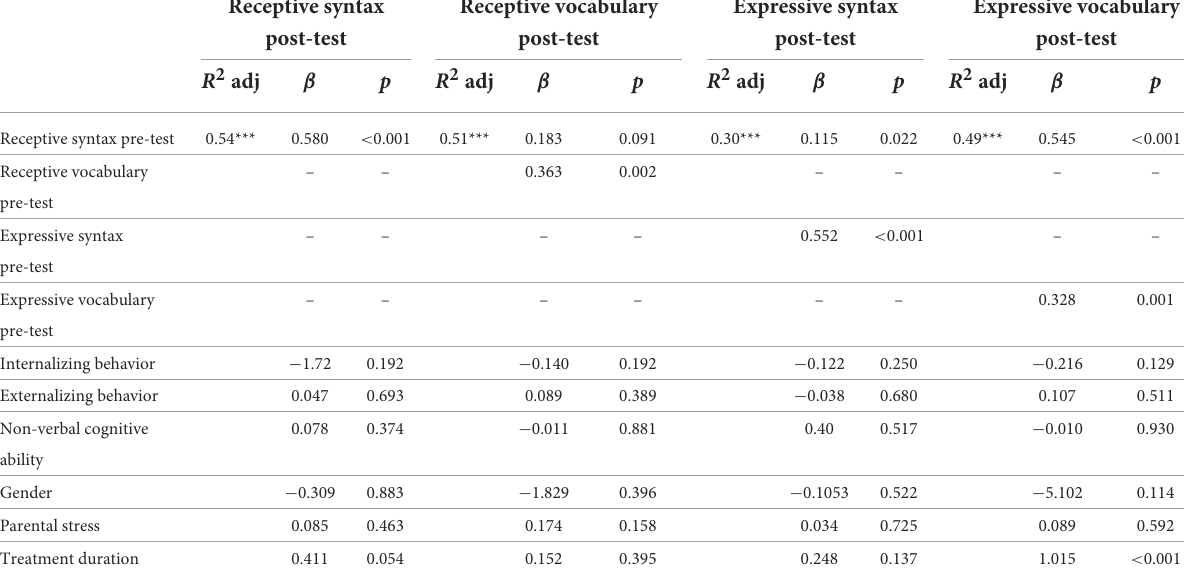
TABLE 4 Results of the regression analyses with the dependent variables: receptive syntax post-test, receptive vocabulary post-test, expressive syntax post-test and expressive vocabulary